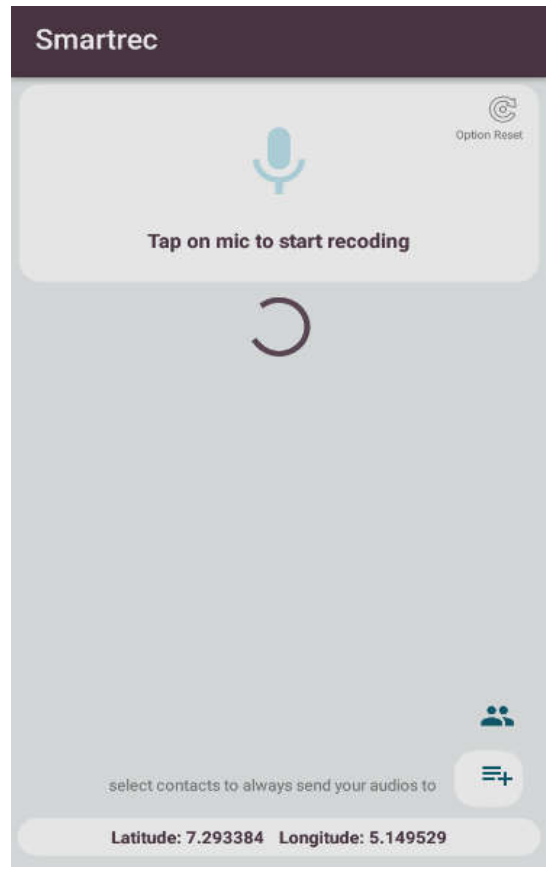
Figure 9 . Recording Interface